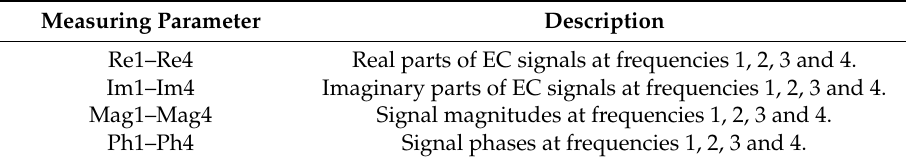
Table 2. Measuring parameters from multi-frequency Eddy Current